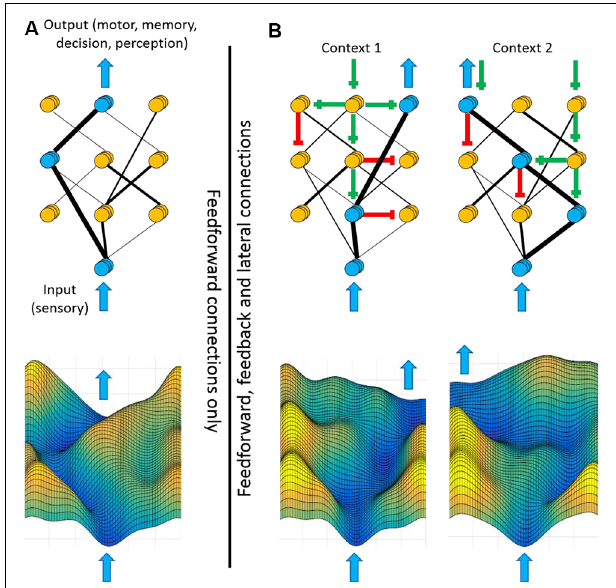
FIGURE 7 | Feedback shapes the cortical landscape according to context. Framework for how feedback pathways may contribute to flexible sensory-motor processing. Top panels illustrate hierarchically-arranged cortical nodes with input regions at the bottom and output regions at the top. Blue arrows represent sensory inputs (bottom) or cortical outputs (top). Blue nodes represent highly active regions whereas yellow nodes represent less active regions. Black lines represent the structural and functional connectivity between nodes, with thicker lines depicting stronger connectivity. Bottom panels are energy landscape representations of the above networks. The height of each contour reflects the energy barrier of propagating into that region. (A) If signal processing between cortical regions is defined only by feedforward connections, then sensory-motor processing will always follow the strongest connections. (B) Different contexts, such as goal-direction or self-generated movement, can propagate along feedback and laterals pathways [green lines (excitatory) and red lines (inhibitory)]. Consequently, these top-down signals modulate which input and output nodes are enhanced or suppressed, thereby altering the coupling strengths between cortical regions (black lines). The same input signal may now be routed to diverse outputs, as appropriate for the current context. As illustrated in the bottom panels, modulations of activity levels within individual regions and coupling strengths between regions change the contours of the cortical landscape, favoring different input-output